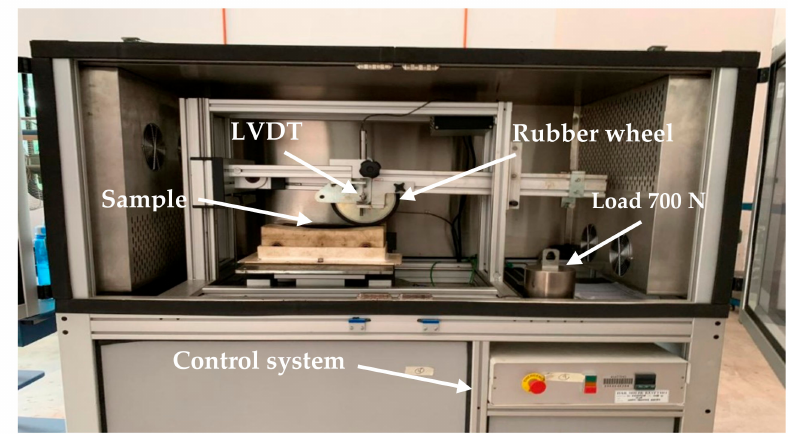
Figure 3. Setup of the single arm wheel-tracking test.